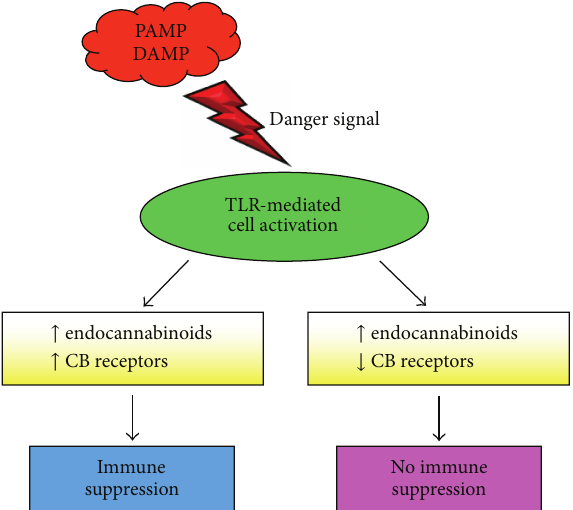
Figure 3: Interaction between TLR-mediated activation and endo- cannabinoid system. PAMPs and DAMPs provide dangers sig- nals that activate innate immune cells via TLRs. Activated cells increase endocannabinoid levels that may suppress the inflamma- tory response. Cell activation may increase or decrease cannabinoid receptor expression. Increased receptor expression in the presence of endocannabinoids promotes immune suppression. Decreased receptor expression may render cells resistant to cannabinoid- mediatedimmunesuppression,andtheinflammatoryresponsecon- tinues. PAMPs: pathogen-associated molecular patterns; DAMPs: damage-associated molecular patterns; TLR: Toll-like receptors; CB: